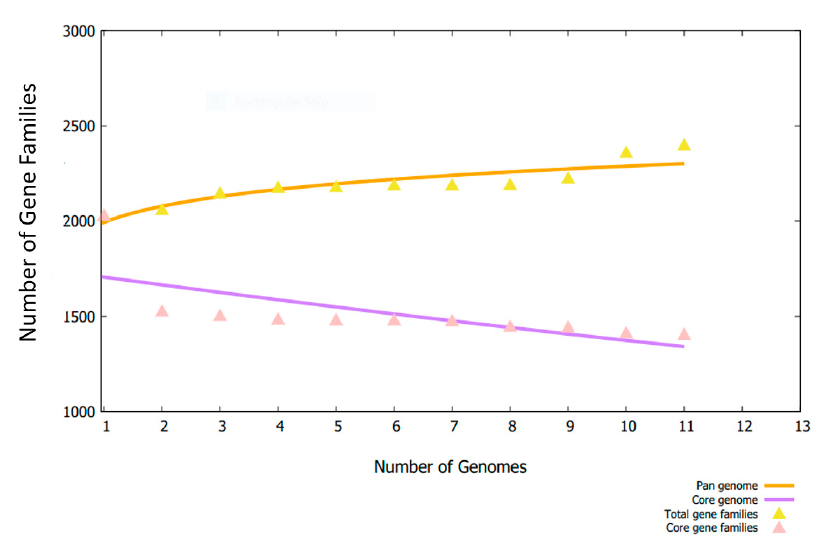
Figure 2. Each strain’s genome size is presented herein. On the x ‐ axis number of genomes is provided while on the y ‐ axis number of gene families in each genome is presented.